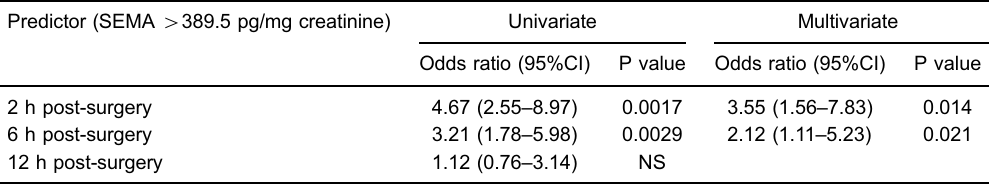
Table 4. Prediction of acute kidney injury in univariate and multivariate